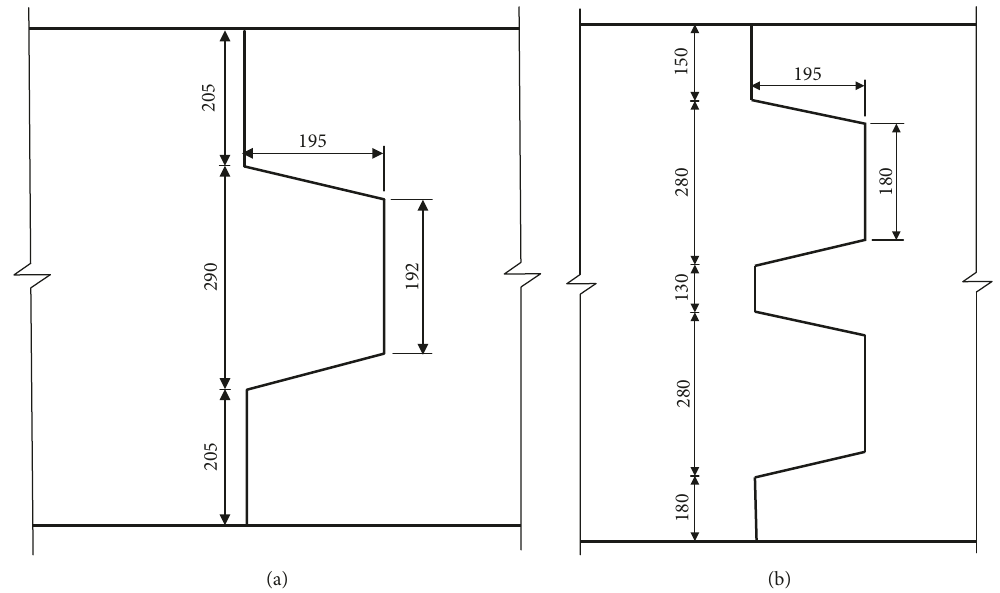
Figure 4: The joint size of (a) single-tenon and (b) double-tenon.